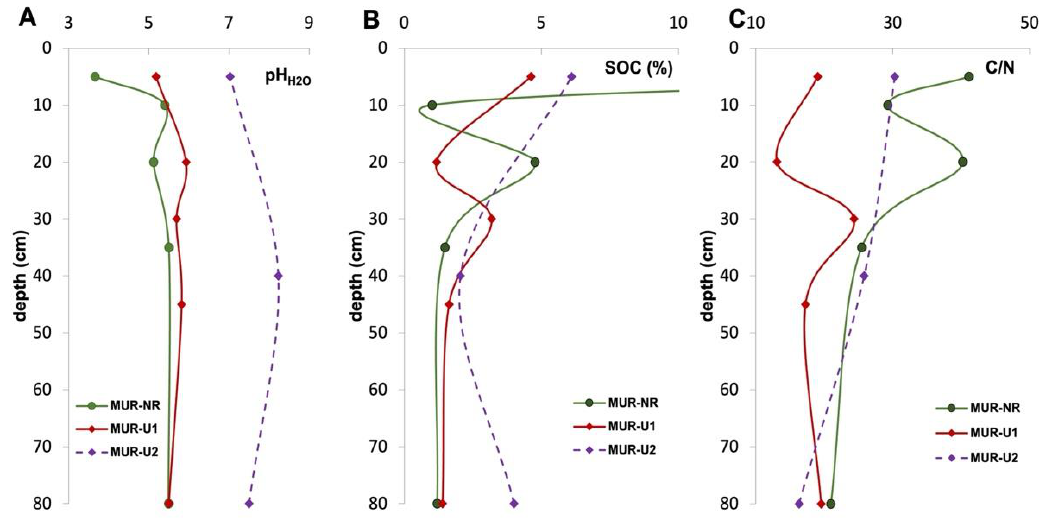
Figure 3. Changes in pH H2O ( A ), SOC ( B ), and C/N ( C ) down the profile of urban and natural soils.